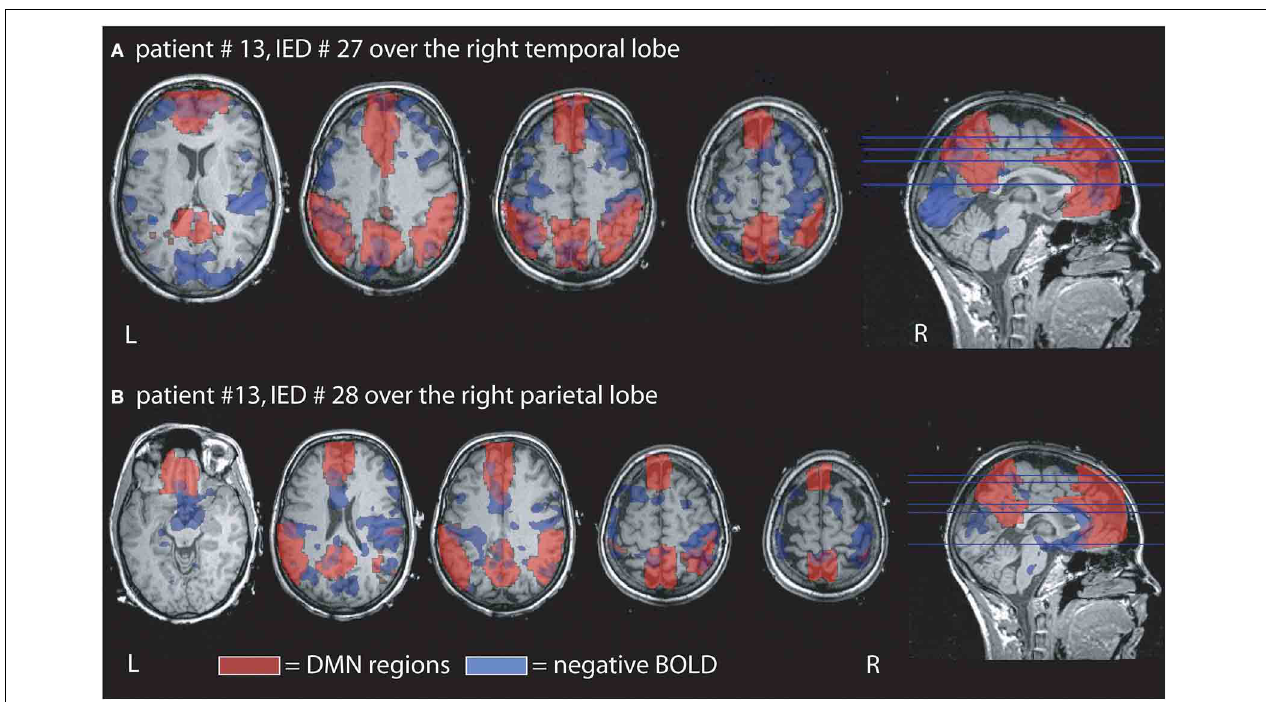
FIGURE 3 | Example of the overlap between negative BOLD responses and DMN regions. Patient # 13 had two different IED one generated over the right temporal and the other over the right parietal region. (A) Demonstrates that overlap for the temporal IED with 15% of the negative BOLD located within the DMN and 29% of the DMN covered by negative BOLD. In agreement with our findings the overlap